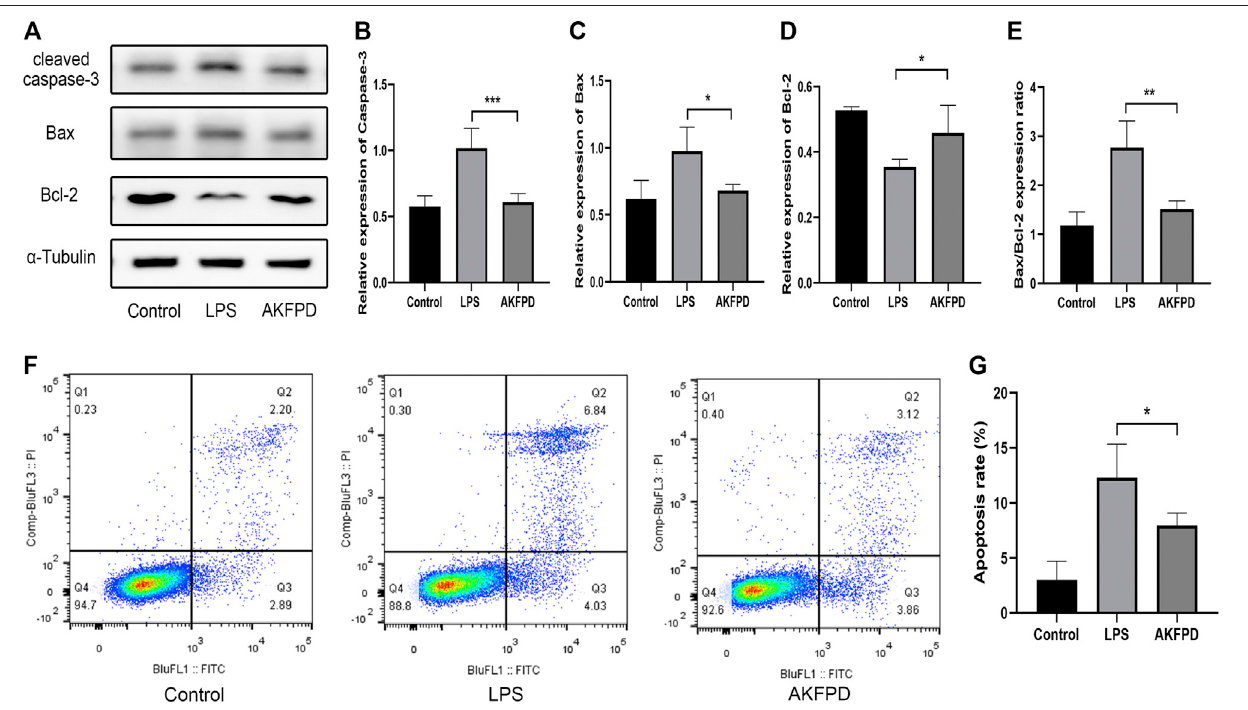
FIGURE 5 | Fluorofenidone ameliorated mitochondrial-mediated apoptosis in vitro . Western-blot (A) and quantitative analysis of cleaved caspase-3, (B) Bax, (C) Bcl-2, (D) andtheratioofBaxtoBcl-2 (E) indifferentgroupsofMLE-12cells. (F,G)